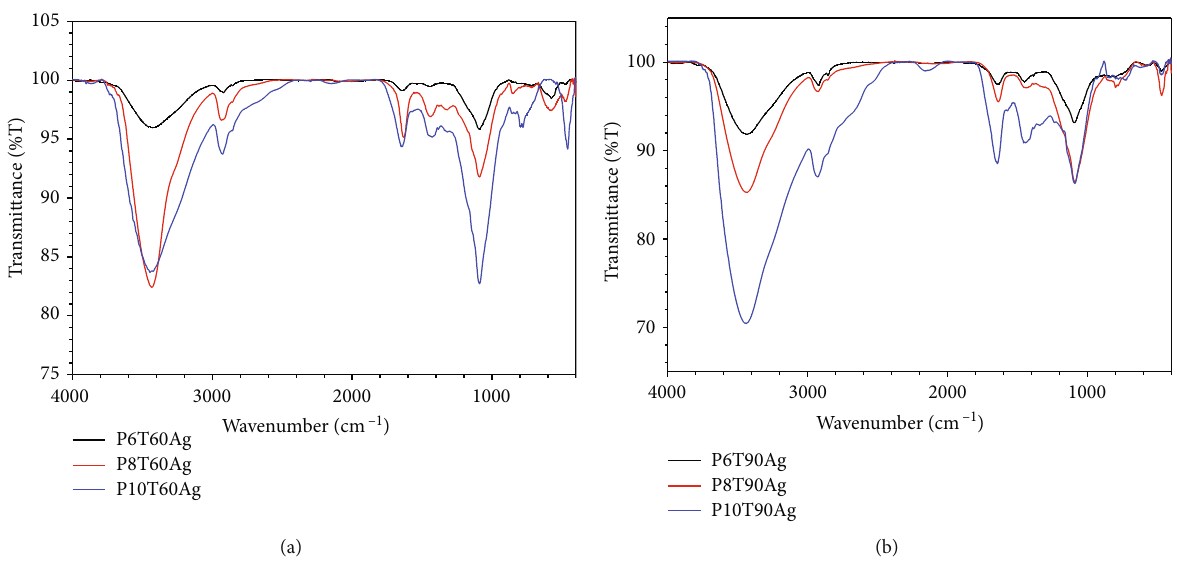
Figure 1: FTIR spectra of (a) P6T60Ag, P8T60Ag, and P10T60Ag and (b) P6T90Ag, P8T90Ag, and